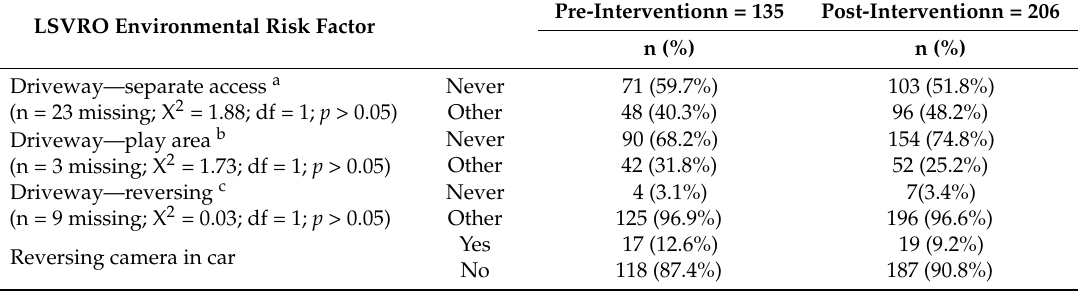
Table 3. LSVRO Environmental Risk Factors.